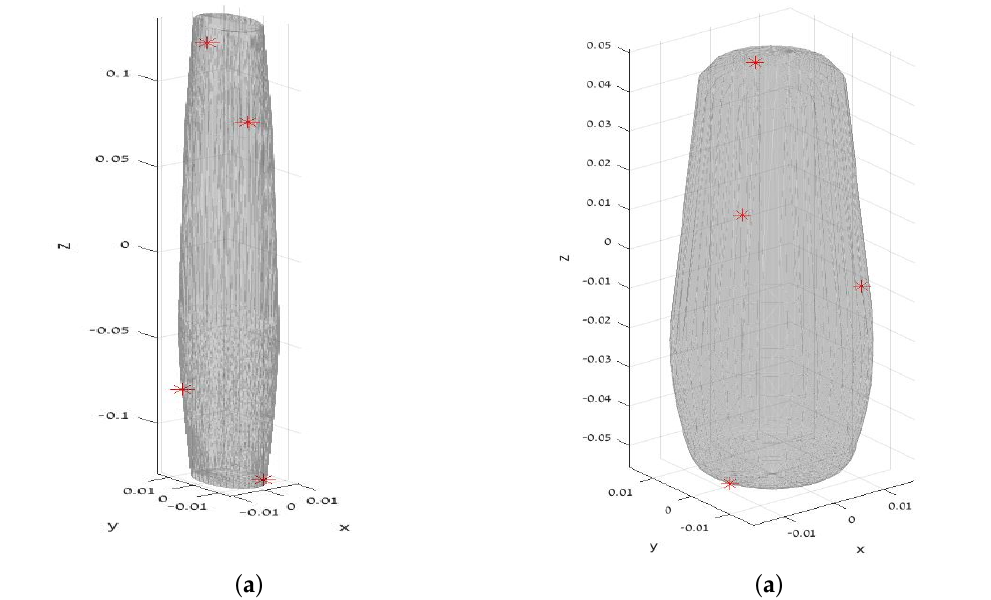
Figure 7. From left to right: ( a ) hammer handle, power, low µ s ; ( b ) screwdriver handle, power, high µ s